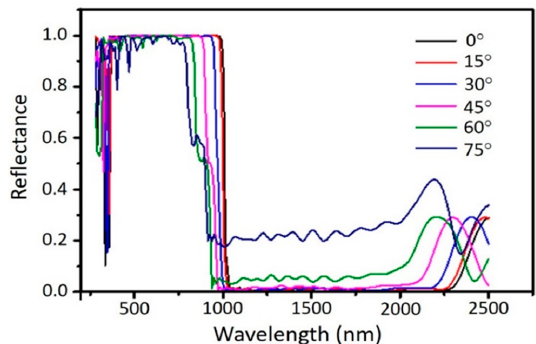
Figure 6. Simulation results on solar spectrum splitting by dichroic mirror with different angle off incident.